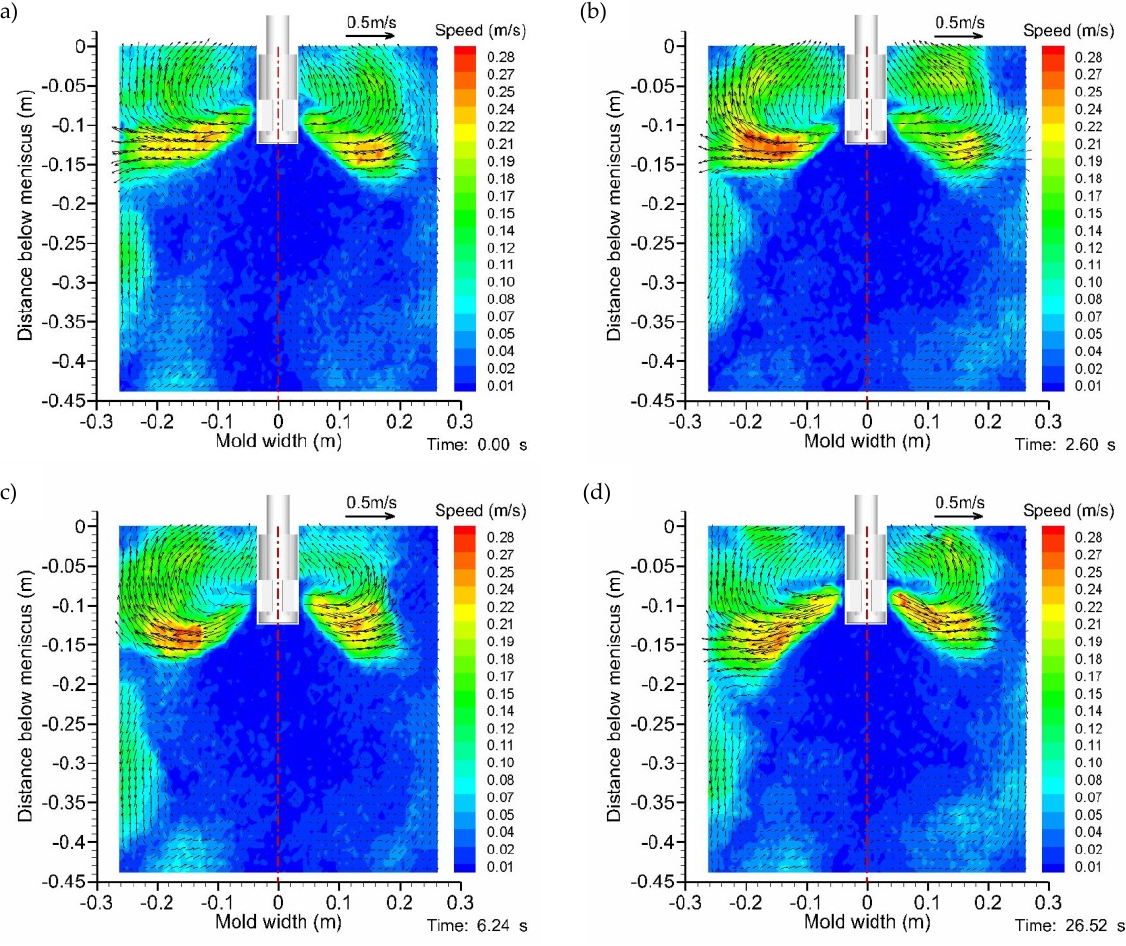
Figure 15. The instantaneous velocity field of gas–liquid two-phase flow in the wide slab continuous casting mold changes with time: ( a ) 0.00 s, ( b ) 2.60 s, ( c ) 6.24 s, ( d ) 26.52 s.